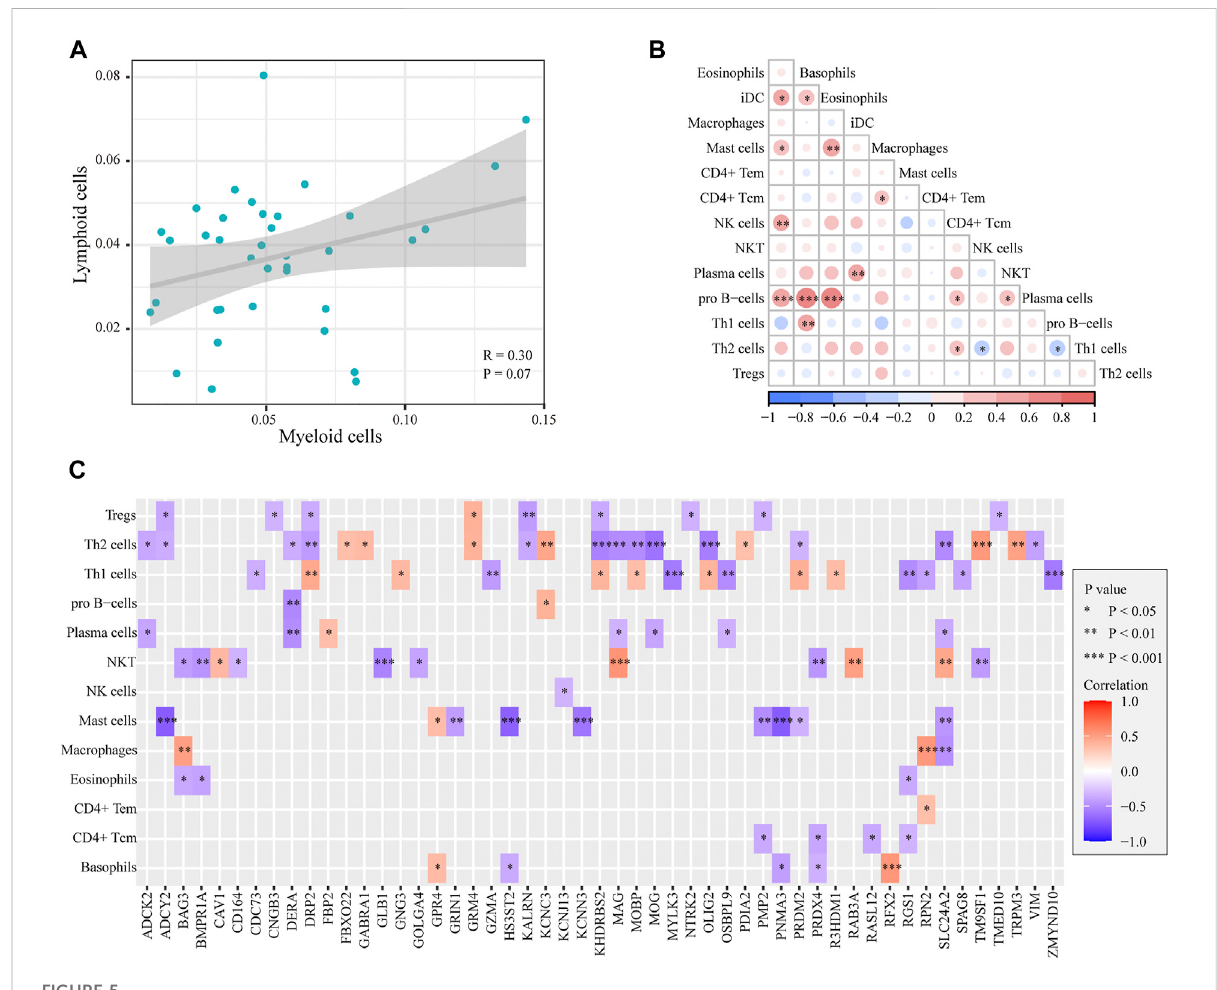
FIGURE 5 Correlation between myeloid cells and lymphoid cells in ADs. (A) . Plot of the correlation between myeloid cells and lymphoid cells: no signi fi cantdifferencewasdetected( p =0.07). (B) .Heatmapofthecorrelationbetweenimmunecells:aclosecorrelationbetweenimmunecells. (C) . Heatmap of the correlation between cell scores and genes: 51 marker genes were signi fi cantly associated with the differentially expressed